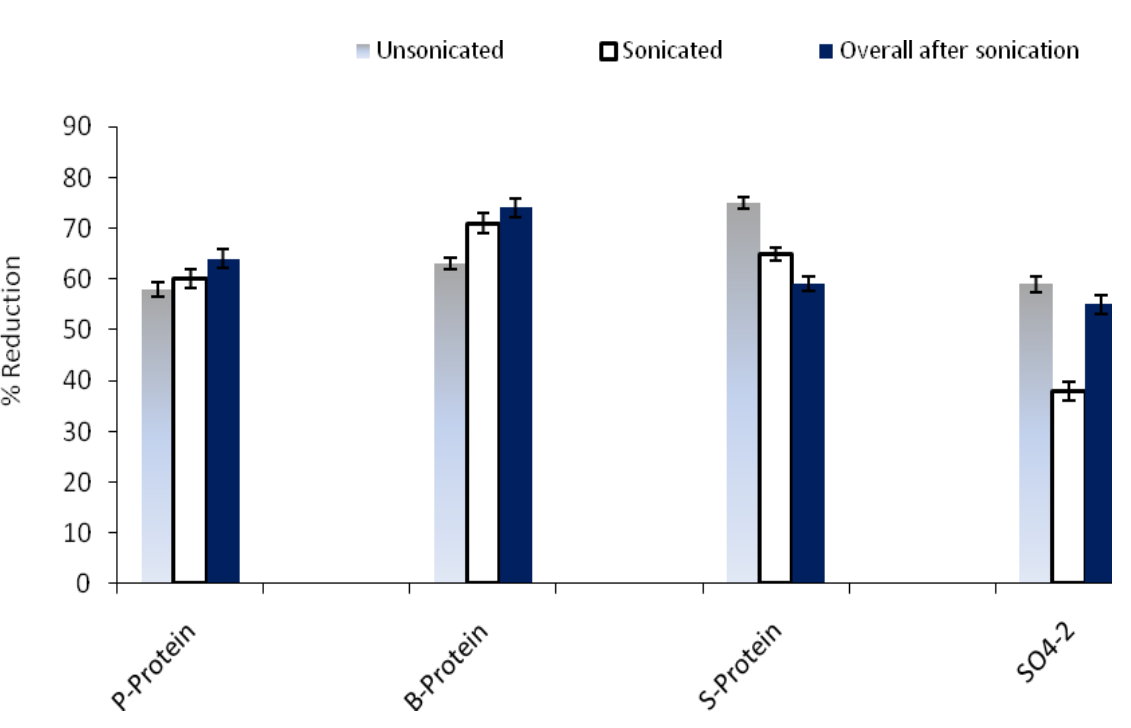
Figure 3. Degradation efficiency of particulate protein, bound protein, soluble protein and